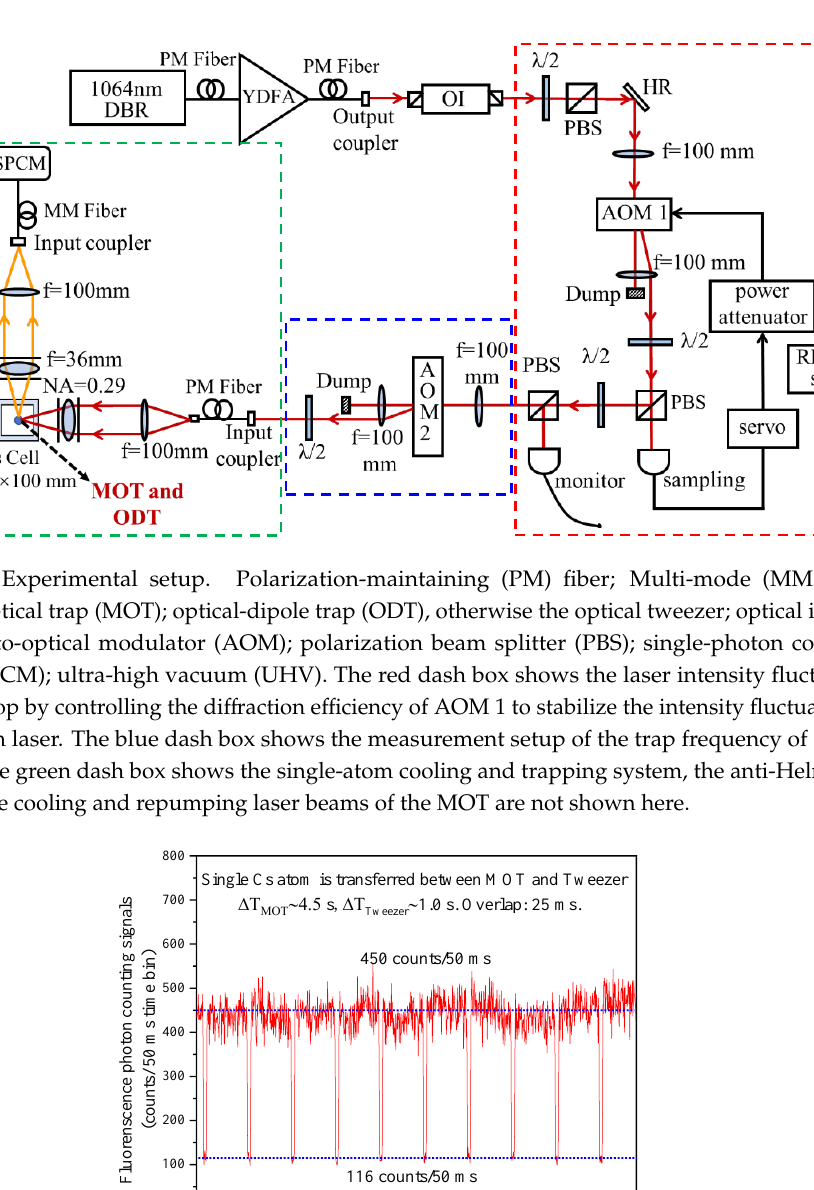
Figure 7. Trap frequency and double frequency of the 1064-nm optical tweezer. Transfer efficiency goes an apparent decline when the modulation frequency is resonant or near-resonant to the trap frequency and its double frequency of the optical tweezer and reaches a minimum at resonance. The photon scattering rate of the optical tweezer is [24]